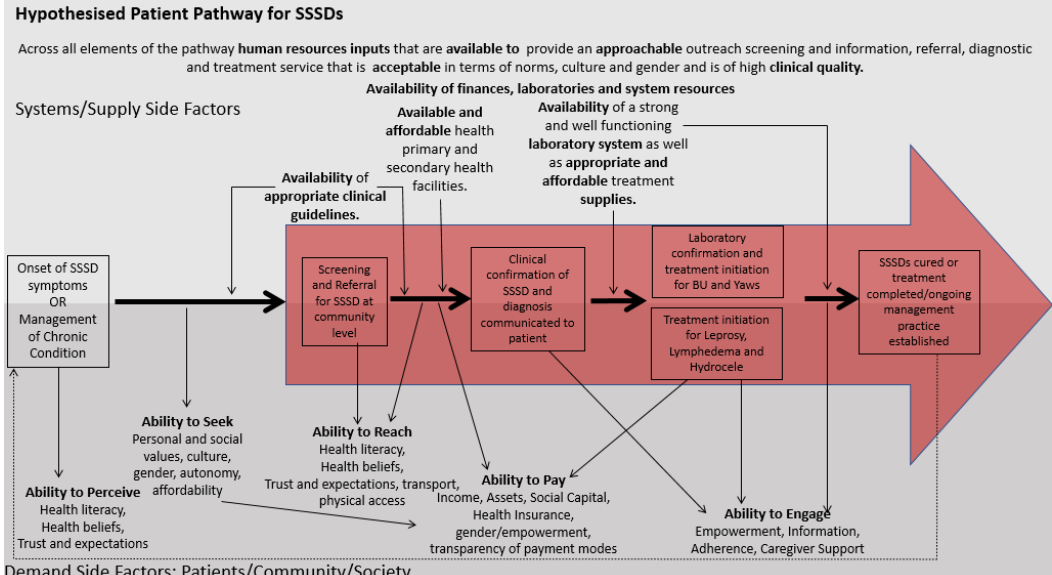
Figure 2. REDRESS hypothesised patient pathway for SSSDs. Reprinted/adapted with permission from (Levesque et al. 2013). Patient-Centred Access to Health Care: Conceptualising Access at the Interface of Health Systems and Populations. International Journal for Equity in Health 12: 18. https://doi.org/10.1186/1475-9276-12-18. © 2013 Levesque et al.; licensee BioMed Central Ltd.